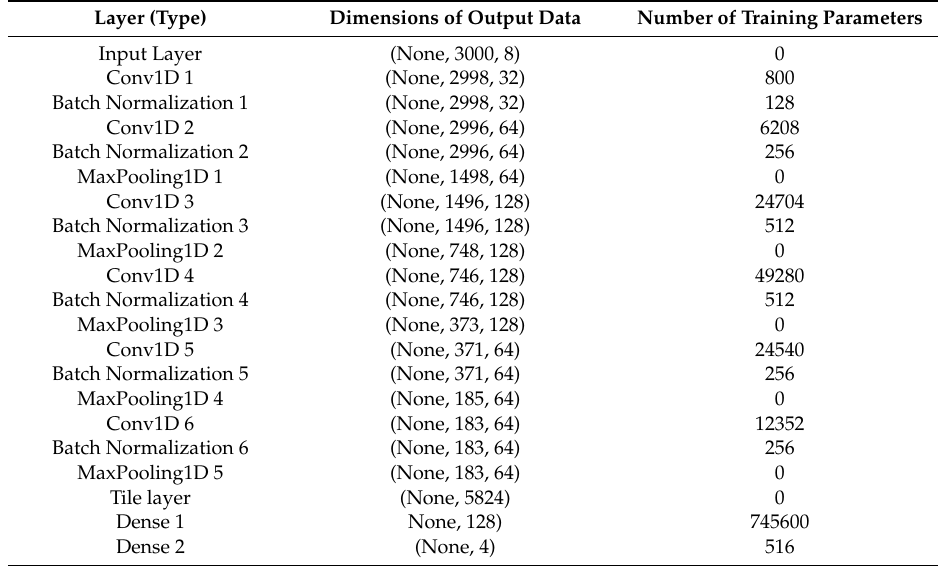
Table 2. 1-D CNN multi-measurement point reciprocating compressor gas valve fault diagnosis model